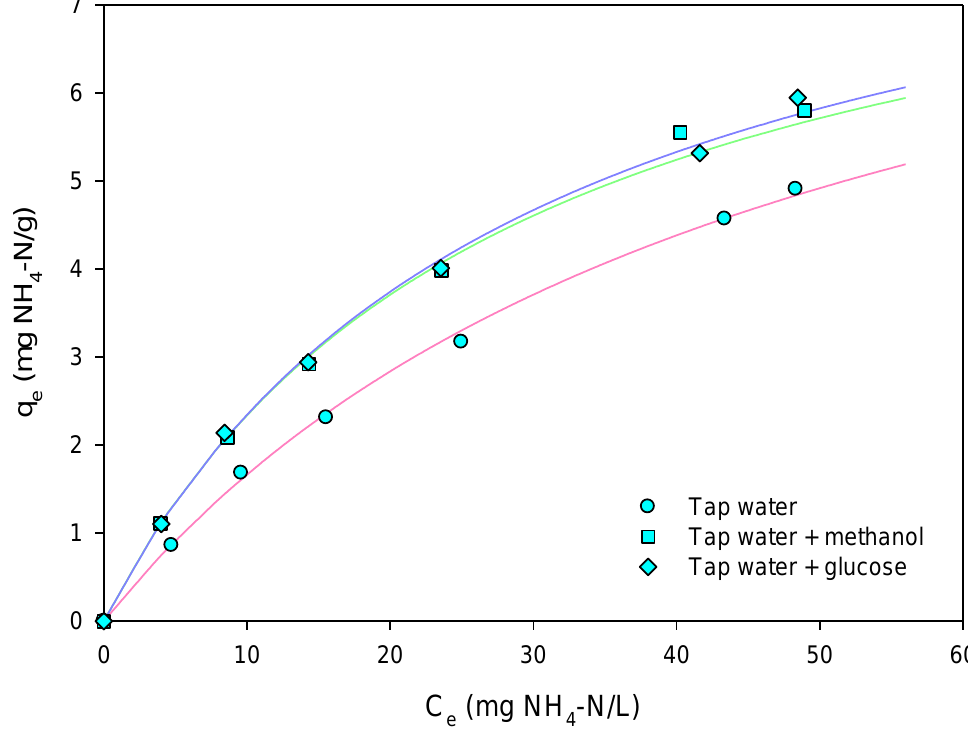
Figure 6. Comparison of isotherms performed with tap water and fortified tap water enriched with different organic substrates. Only Langmuir model fit shown.